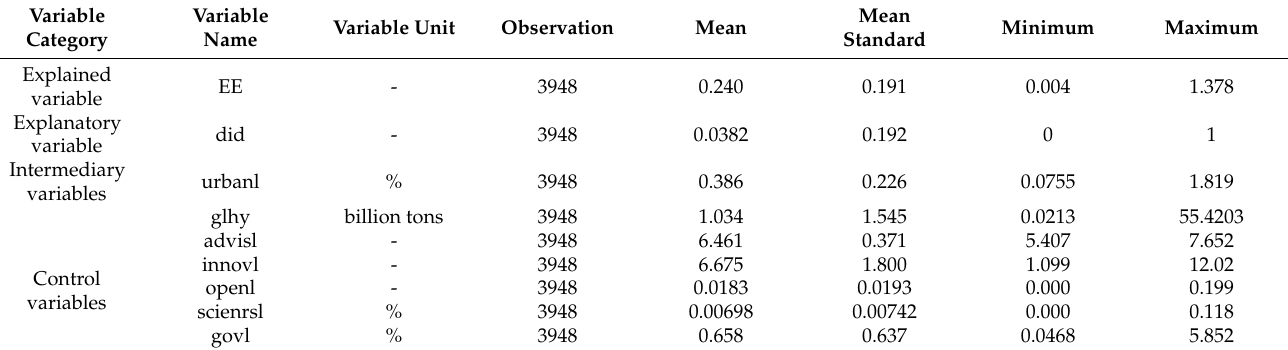
Table 3. Descriptive statistics of